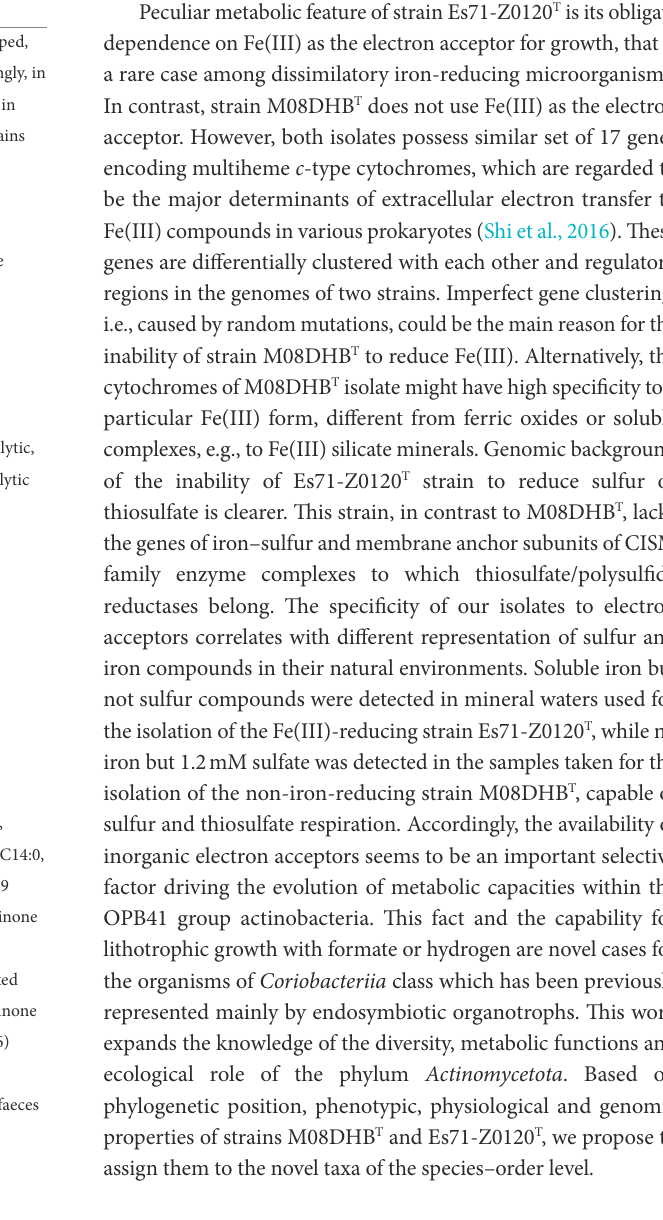
TABLE 2 Comparative characteristics of novel isolates and type representatives of the с lass Coriobacteriia .